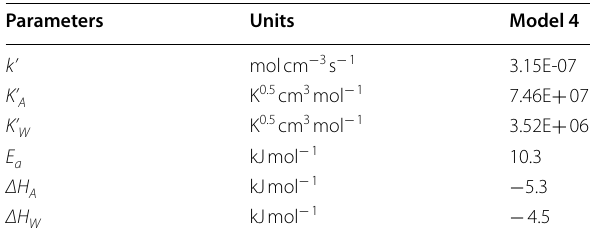
Table 5 The reaction rate constants and adsorption equilibrium constants of Langmuir‑Hinshelwood model 4 using Arrhenius equation